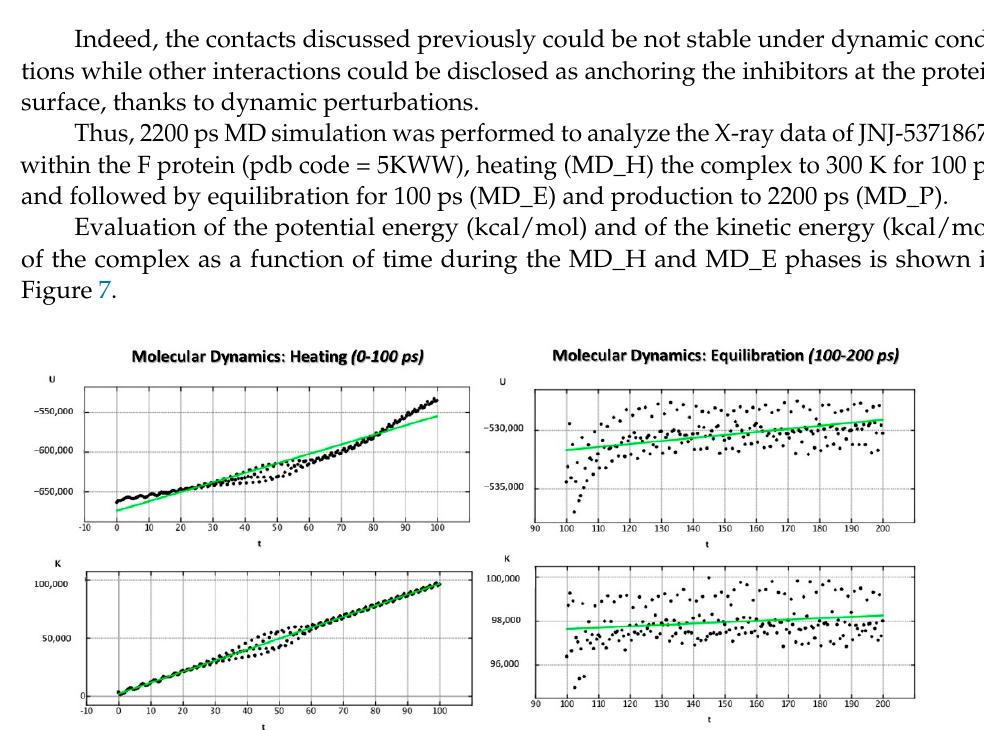
Figure 7. Potential energy (kcal/mol) and kinetic energy (kcal/mol) variation of the 5KWW complex as a function of time during MD_H ( left side ) and MD_E ( right side ) phases. the potential energy (kcal/mol) and of the kinetic energy (kcal/mol) of the complex as a function of time are shown in Figures 8 and 9.